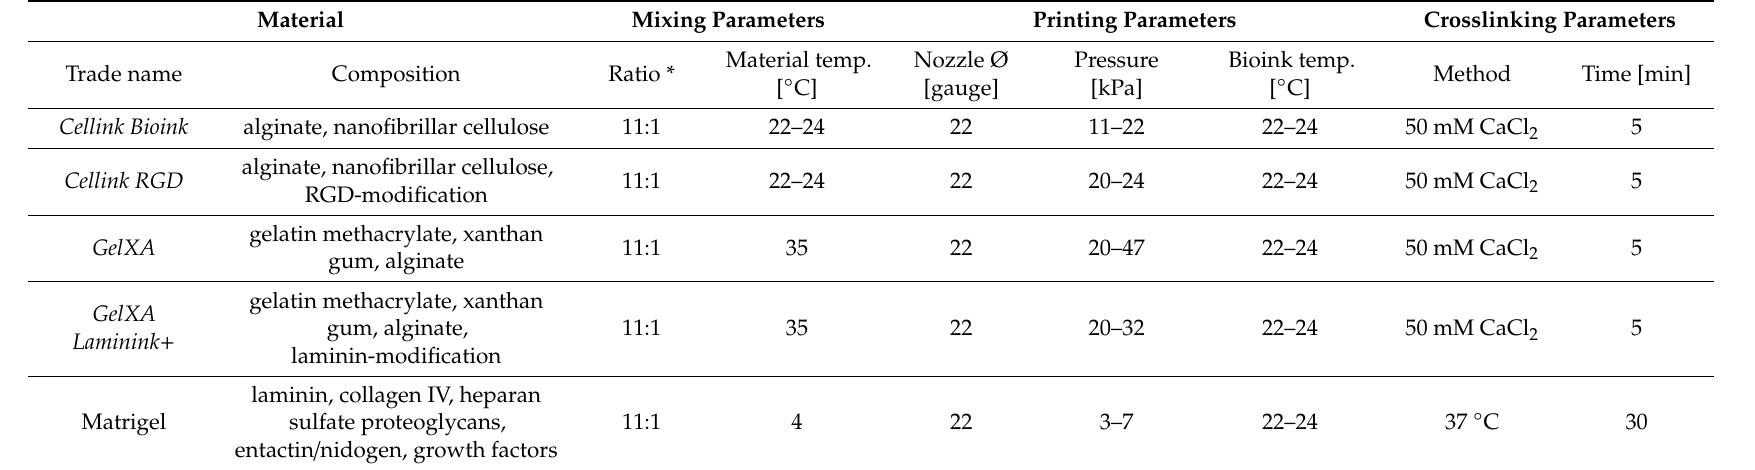
Table 1. Printing